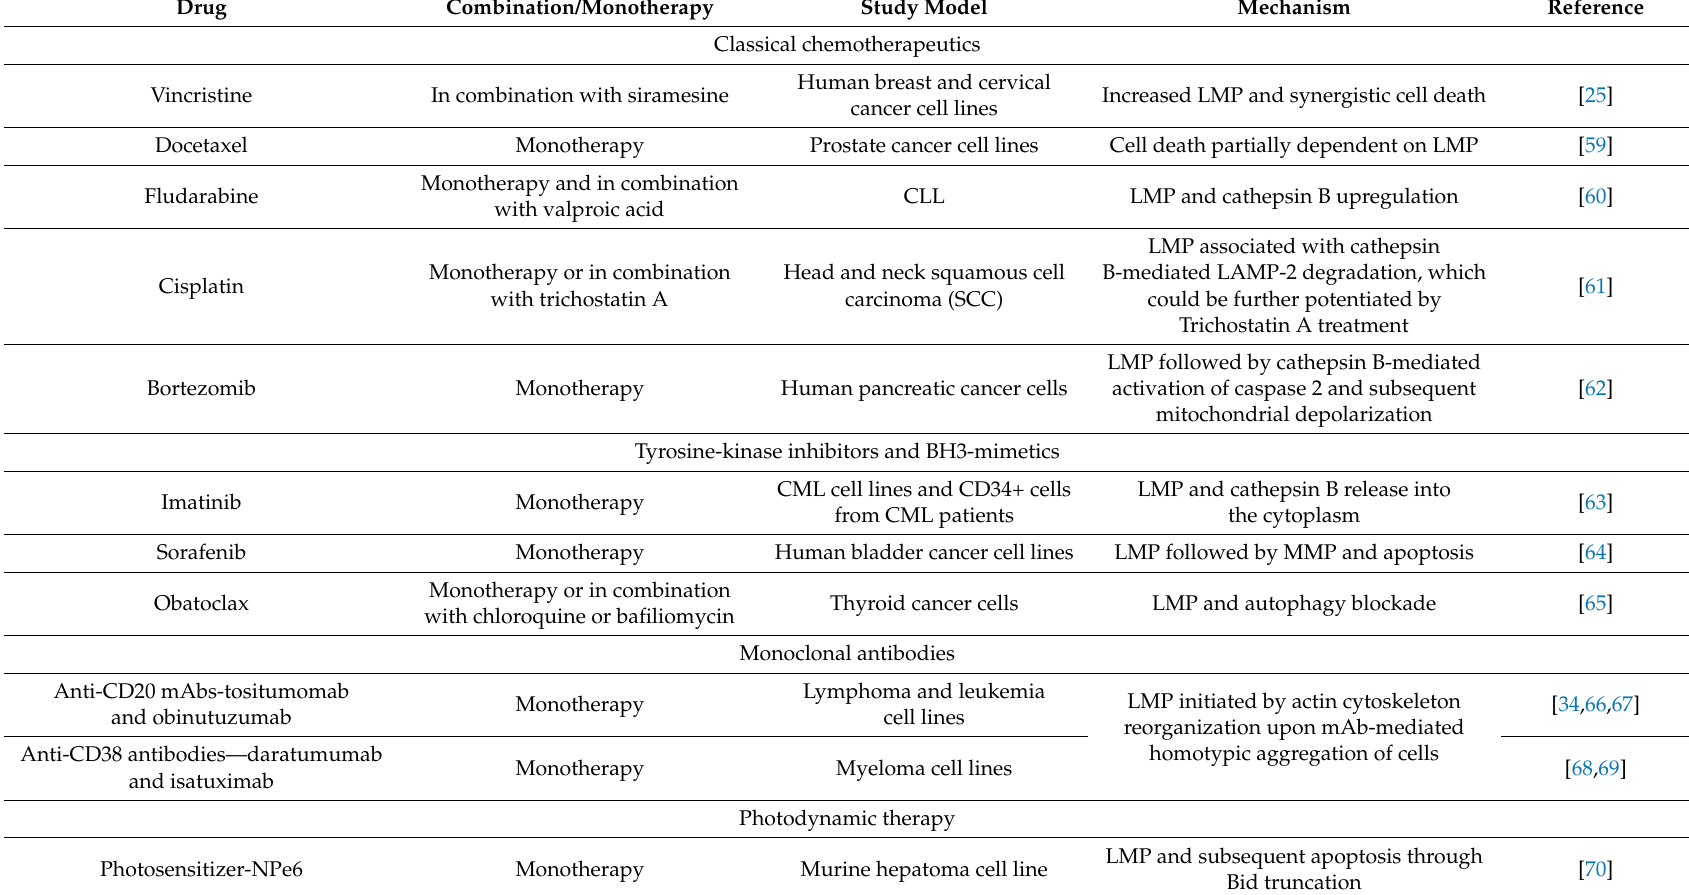
Table 2. List of atypical inducers of lysosomal cell